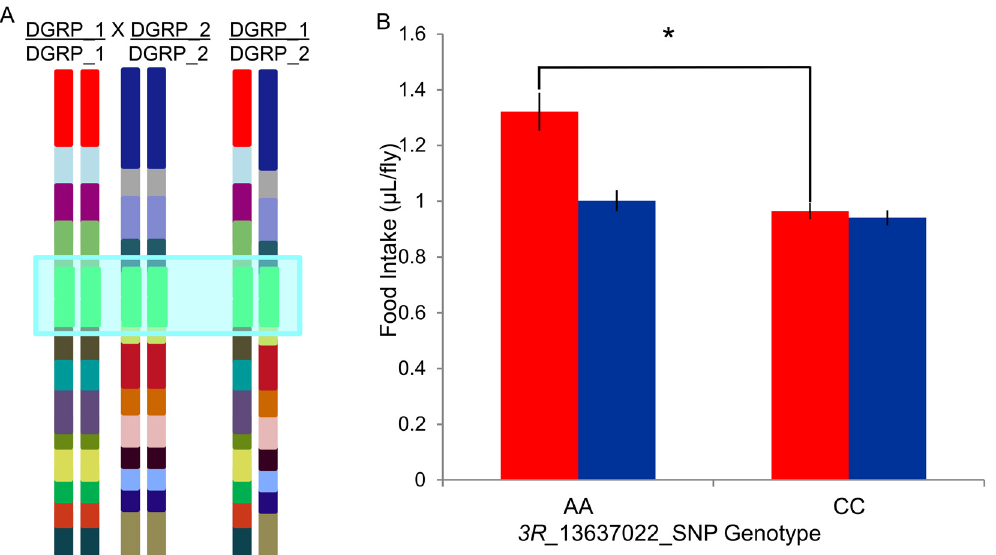
Fig 3. SNP-based functional validation. (A) Mating scheme for generating outbred lines homozygous for major and minor SNP alleles. Two parental genotypes homozygous for the focal highlighted SNP and the tested F 1 genotype are depicted. (B) 3R _13637022_SNP validation results for females (red bars) and males (blue bars) ( ± SE). * : P = 0.029.